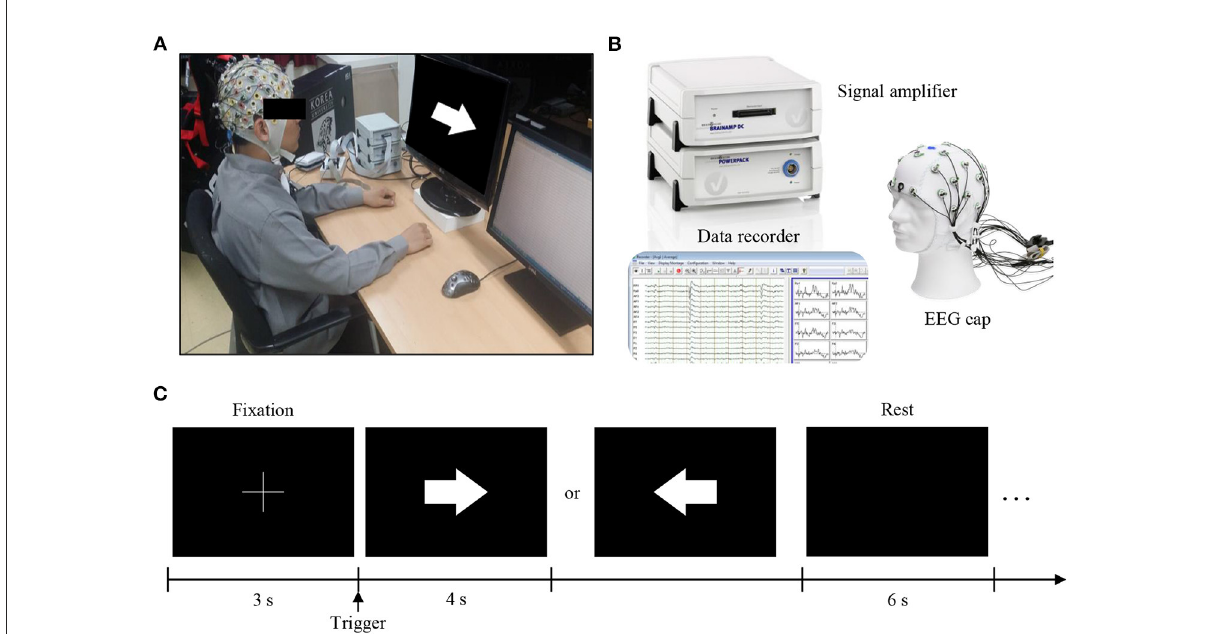
FIGURE2 Experimental setup and protocol. (A) During the experiment, the subjects were seated comfortably in a chair with armrests at 60 ( ± 5) cm in front of a 21-inch LCD monitor. (B) EEG signals were measured using brainwave collection equipment (BrainAmp, BrainProducts GmbH, Germany) and data recorders (BrainVision, BrainProducts GmbH, Germany). (C) In the experimental paradigm, for all blocks, the first 3 s of each trial began with a fixation cross that appeared at the center of the monitor to prepare subjects for the MI task. Afterward, the subject performed the imagery task using the appropriate hand for 4 s when a right or left arrow appeared as a visual cue. After each task, the screen remained blank for 6 s. The given data set provides only 4 s MI